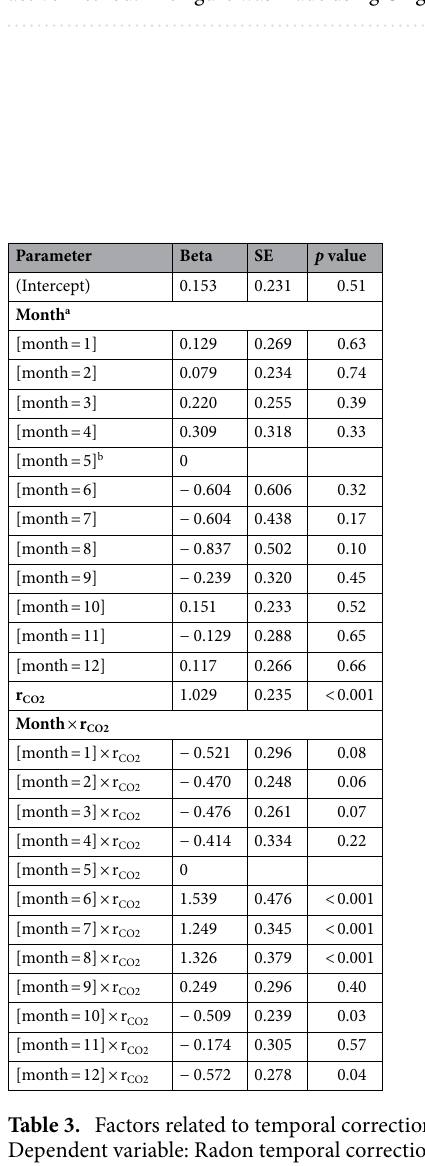
Figure 6. Temporal correction factors for indoor radon concentrations computed at month level using the active method. The figure was made using OriginPro 2019b software (www. origi nlab. com).